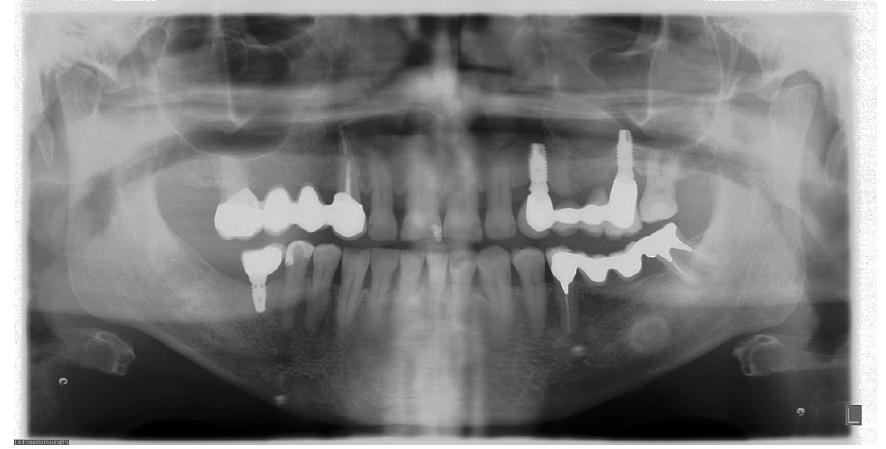
Figure 6 . Backward position. Panoramic radiography. Anterior teeth of both arches are placed be- hind the focal trough, with a consequent increase in their size (incisive teeth seem larger than molar ones). Note the radiopaque band overlapping the mandibular incisive